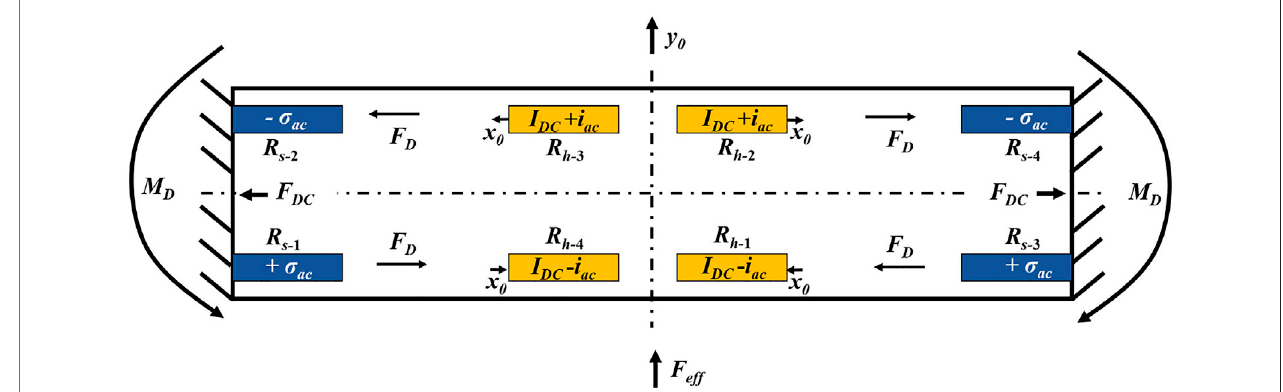
FIGURE 2 | Bias (drive and sense), generated force, displacement, and stress for drive and sense half cycle for a clamped-clamped beam (CCB).